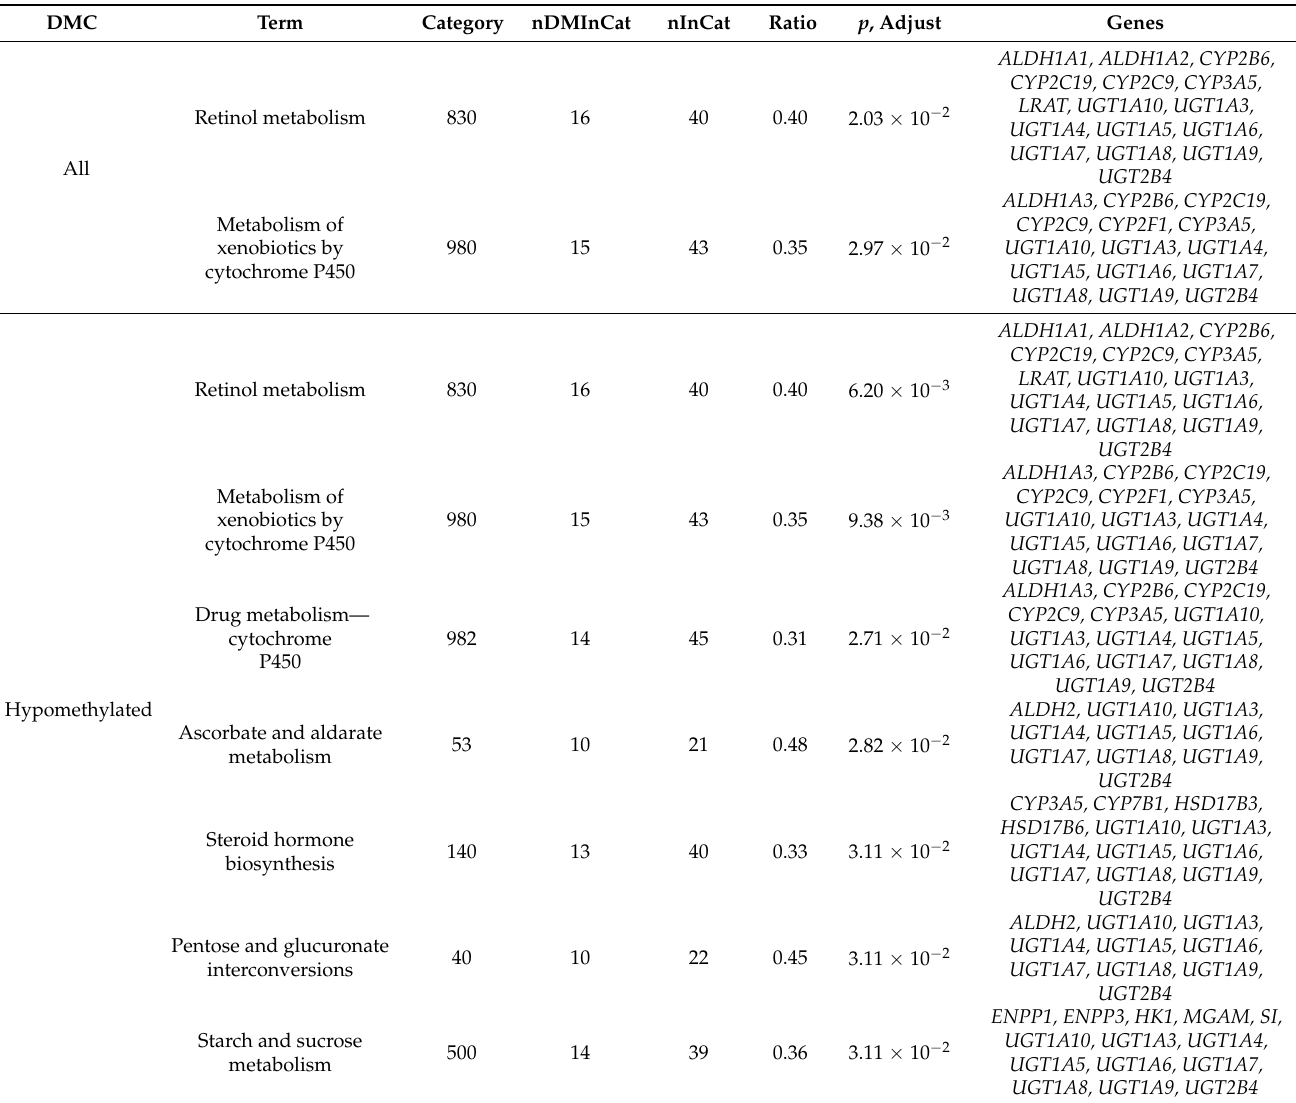
Table 3. Significative KEGG terms (adjusted p -value < 0.05) for mapped DMCs comparing MD patients to